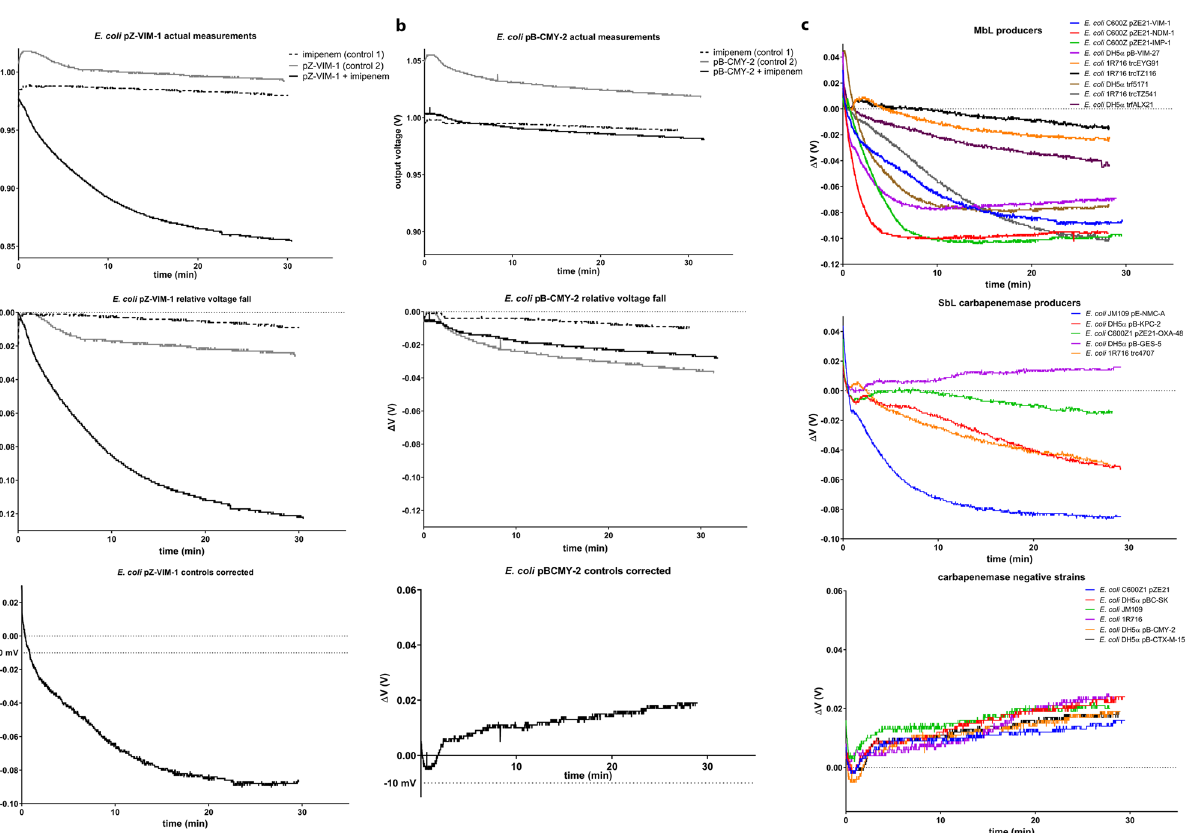
Figure 3. Assays using laboratory E. coli strains directly from bacterial cultures. ( a,b ) : Measurements of clones overproducing the VIM-1 MβL and the CMY-2 class C beta-lactamase. In each experiment three measurements were obtained corresponding to the imipenem solution (control 1), the bacterial suspension (control 2) and their between mixture. The normalized curve of the imipenem-bacterium mix was corrected by subtracting those of the two controls. ( c ) Cumulative data of laboratory strains experiments. Control corrected curves of bacterial suspensions when interacting with imipenem are shown. MβL as well as the majority of SbL carbapenemase producing clones yielded imipenem hydrolysis that was detectable by the ISFET. The strain overproducing the GES-5 carbapenemase and the clones expressing β-lactamases with weak or no imipenemase activity yielded voltage changes in the corrected curves that were greater than